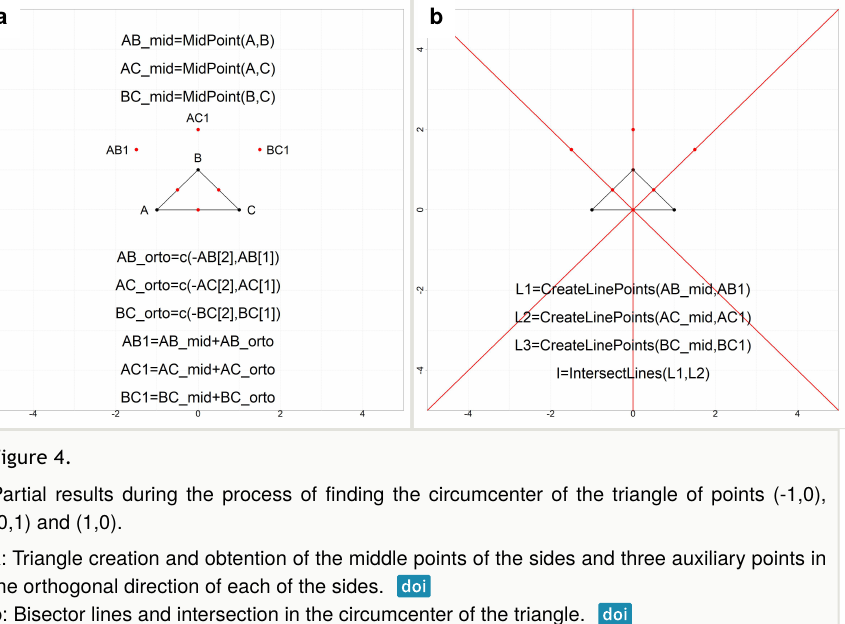
Partial results during the process of fi nding the circumcenter of the triangle of points (-1,0), (0,1) and